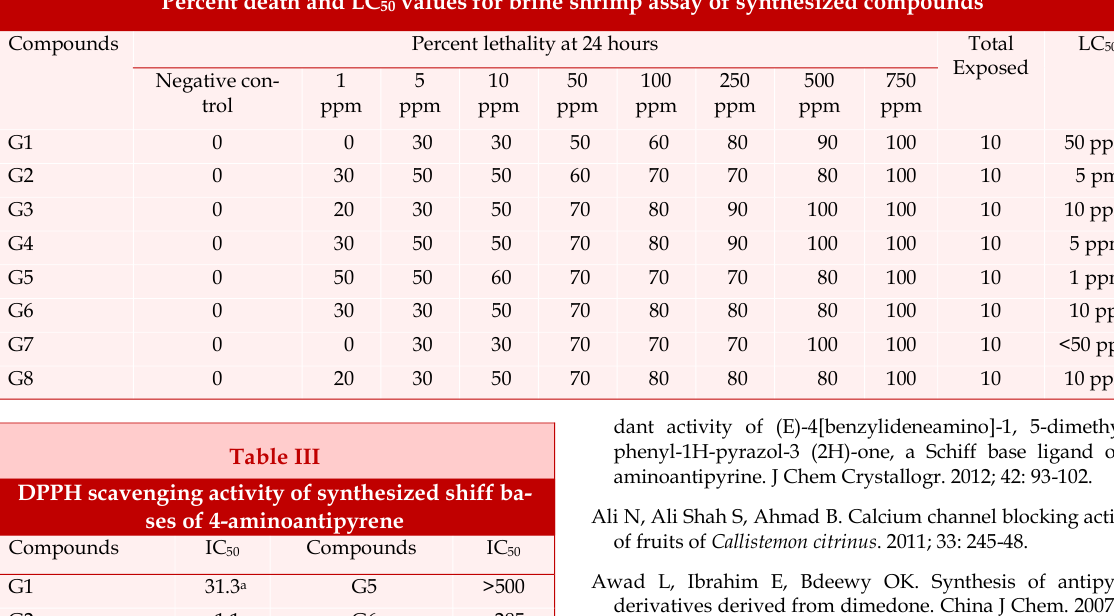
Percent death and LC 50 values for brine shrimp assay of synthesized